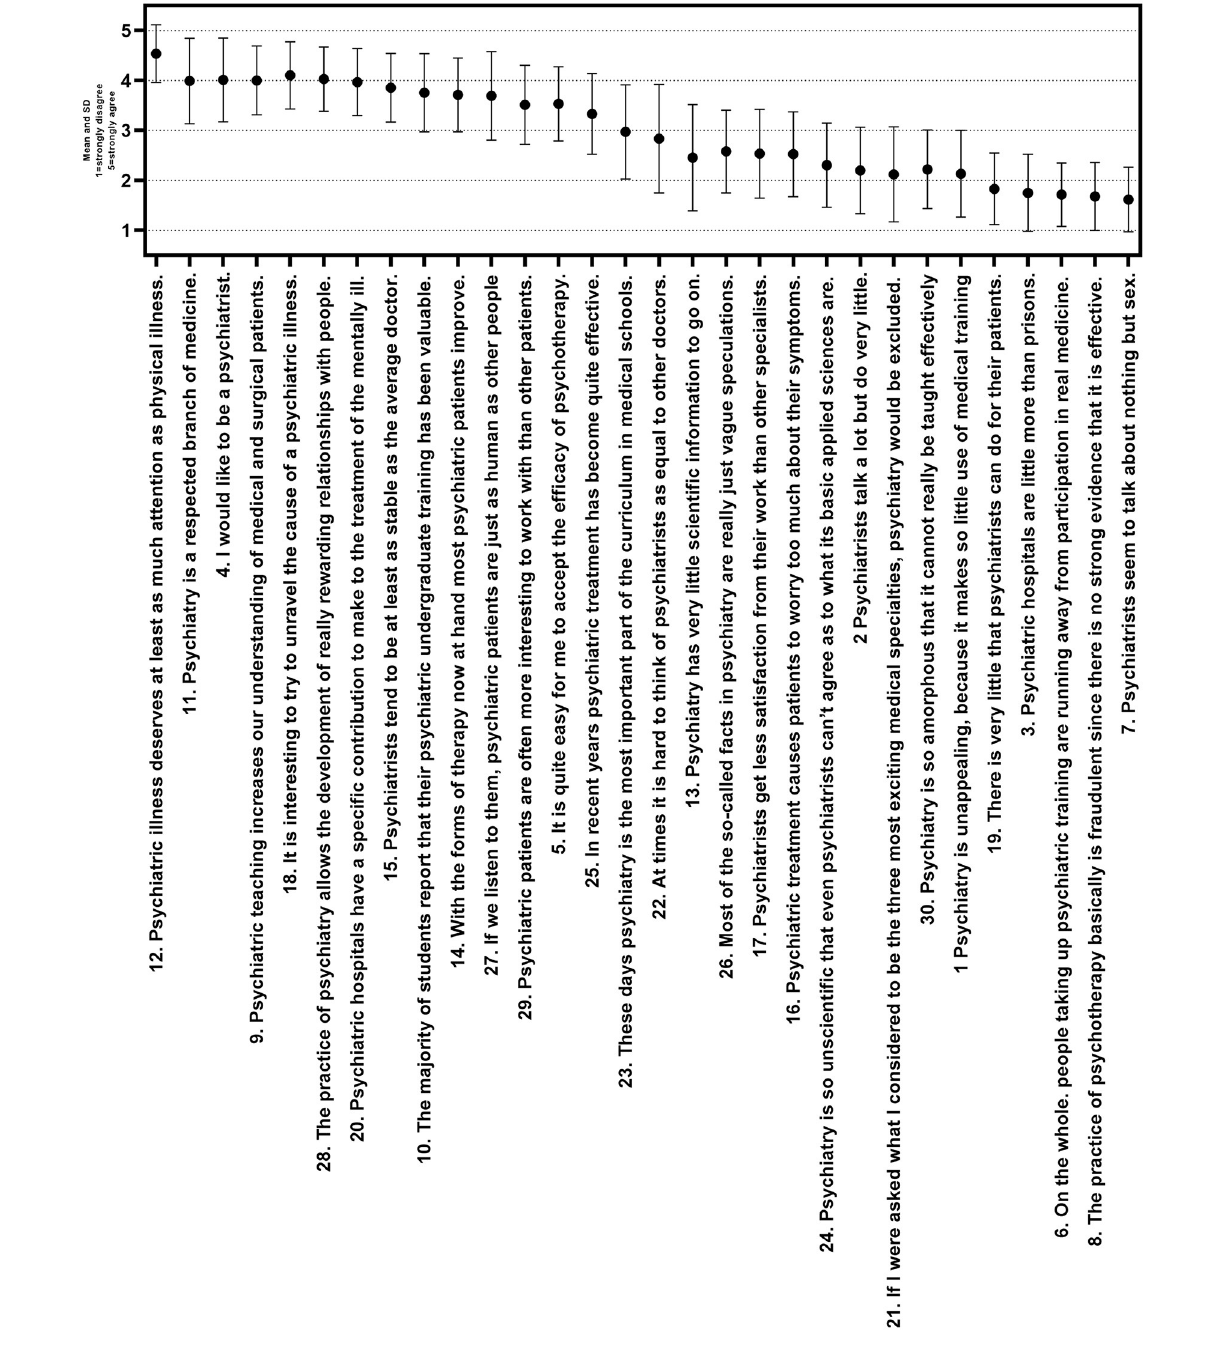
FIGURE 1 | ATP-30 items according to the